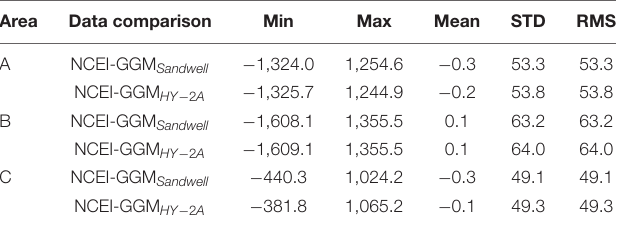
TABLE 5 | Statistics of differences among NCEI data, GGM Sandwell data, and GGM HY − 2 A data in the check points (unit: m).